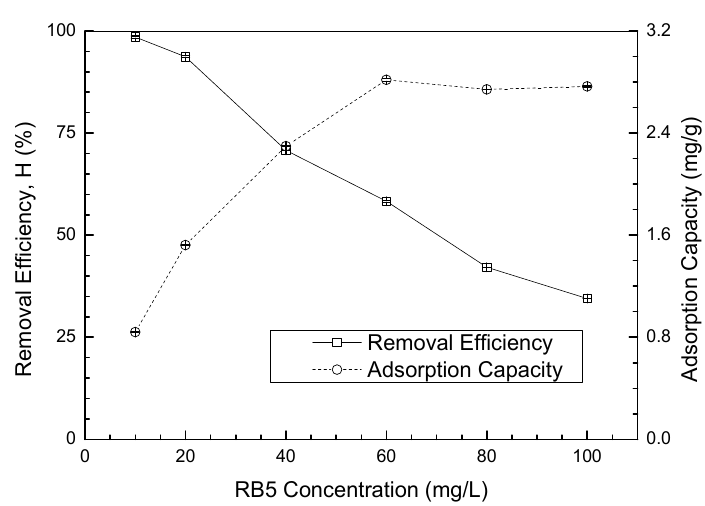
Figure 7. Zeta potential of UBC at different pH.